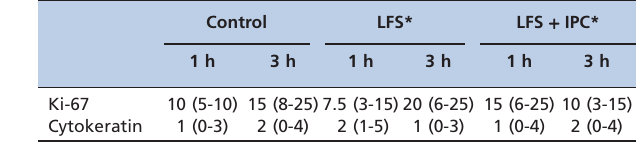
Table 3 - Results of immunohistochemical analyses (median, minimum and maximum values). No differences were observed among the